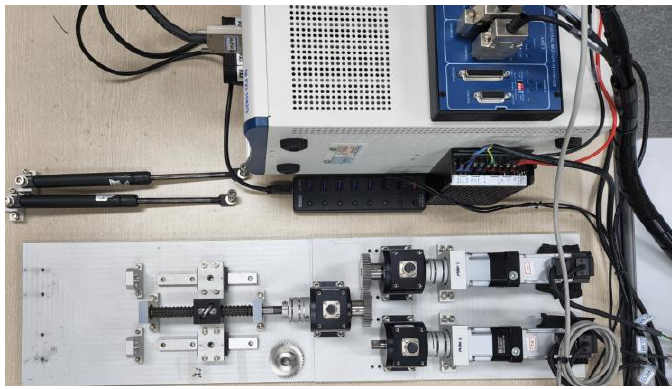
Figure 17. Photograph of the test bed.